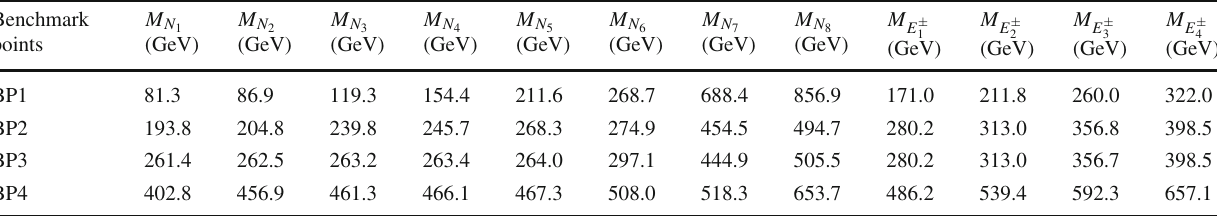
Table 3 Masses of neutral and charged VLLs for four benchmarks Benchmark points